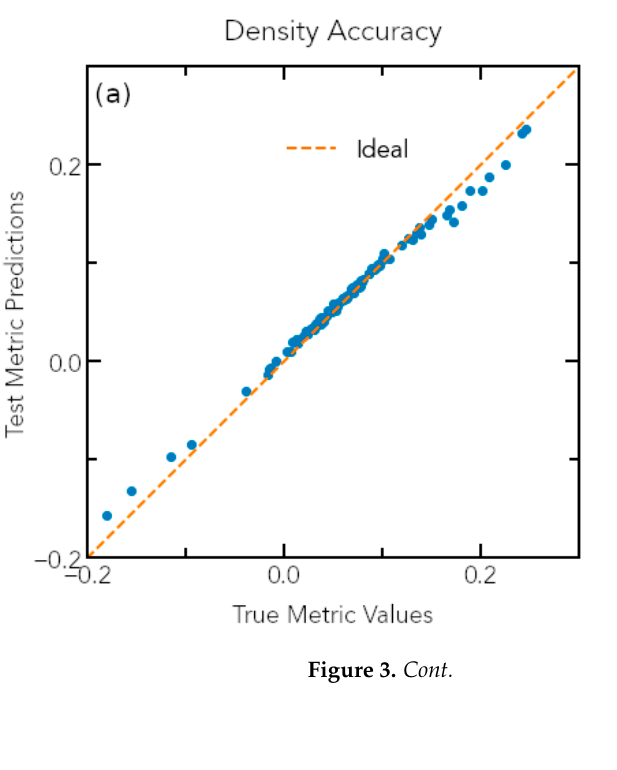
Figure 2. Predicted and true values of the metric defined in Equation (7) for ( a ) binary and ( b ) ternary alloys, demonstrating that the trained CNN was capable of predicting values based solely on compositions and atomic input parameters. The ideal line is a line of slope one and intercept zero—the closer to this line, the closer the CNN is properly predicting metric values.